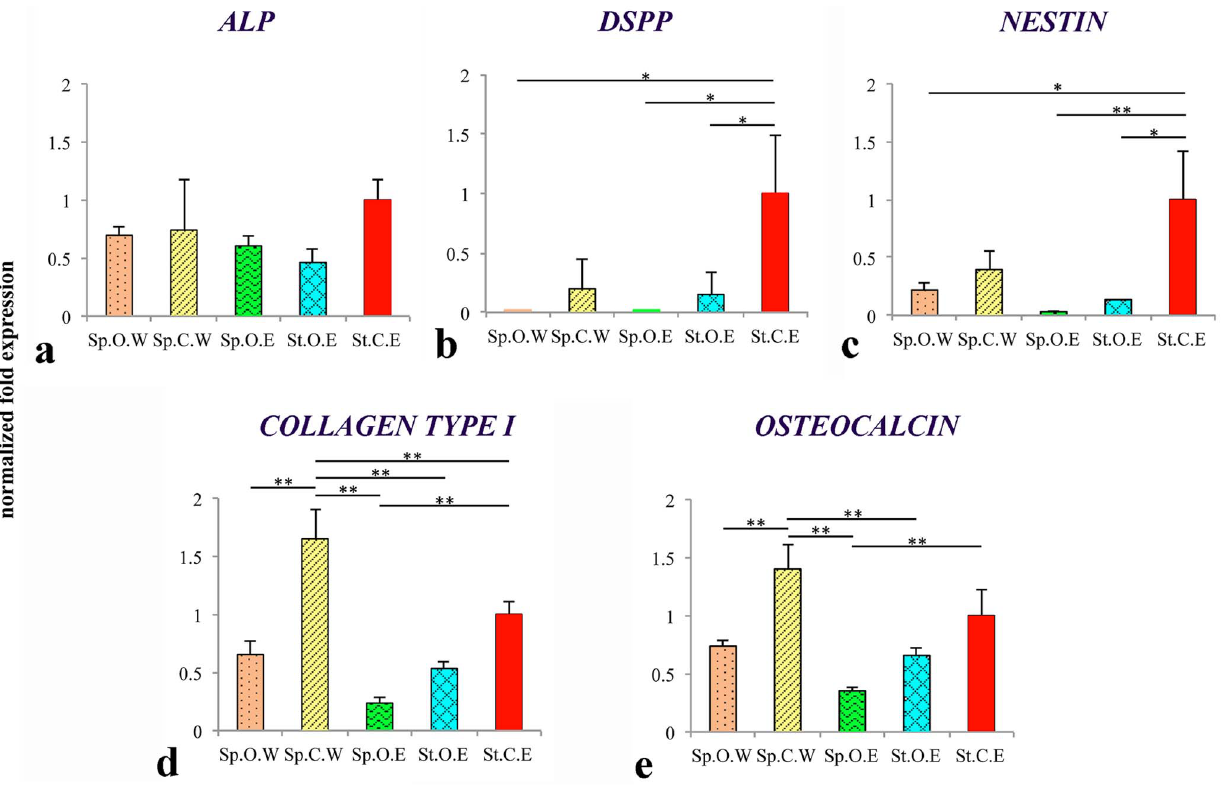
Figure 4. Gene expression analysis. Images showing normalised fold expression against GAPDH for the genes ALP ( a ), DSPP ( b ), Nestin ( c ), Collagen type I ( d ) and Osteocalcin ( e ). Data is shown as average 6 standard deviation of three samples. Asterisks indicate significant ( p , 0.05) or highly significant ( p , 0.01) difference between the groups. Abbreviations: Sp.O.W: spinner flask culture in osteogenic medium with weekly x-ray; Sp.C.W: spinner flask culture in control medium with weekly x-ray; Sp.O.E: spinner flask culture in osteogenic medium with x-ray at the end; St.O.E: static culture in osteogenic medium with x-ray at the end; St.C.E: static culture in control medium with x-ray at the end.